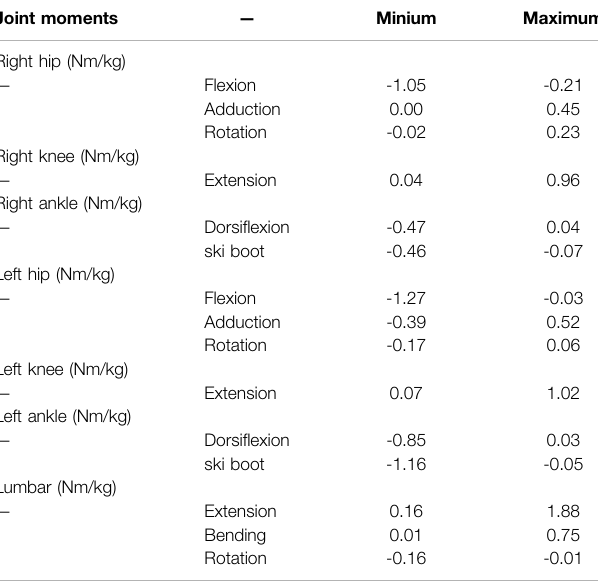
TABLE 2 | Peak joint moments at the lumbar joint as well as the hip, knee and ankle joint of the inside right knee and outside left knee, respectively. Joint